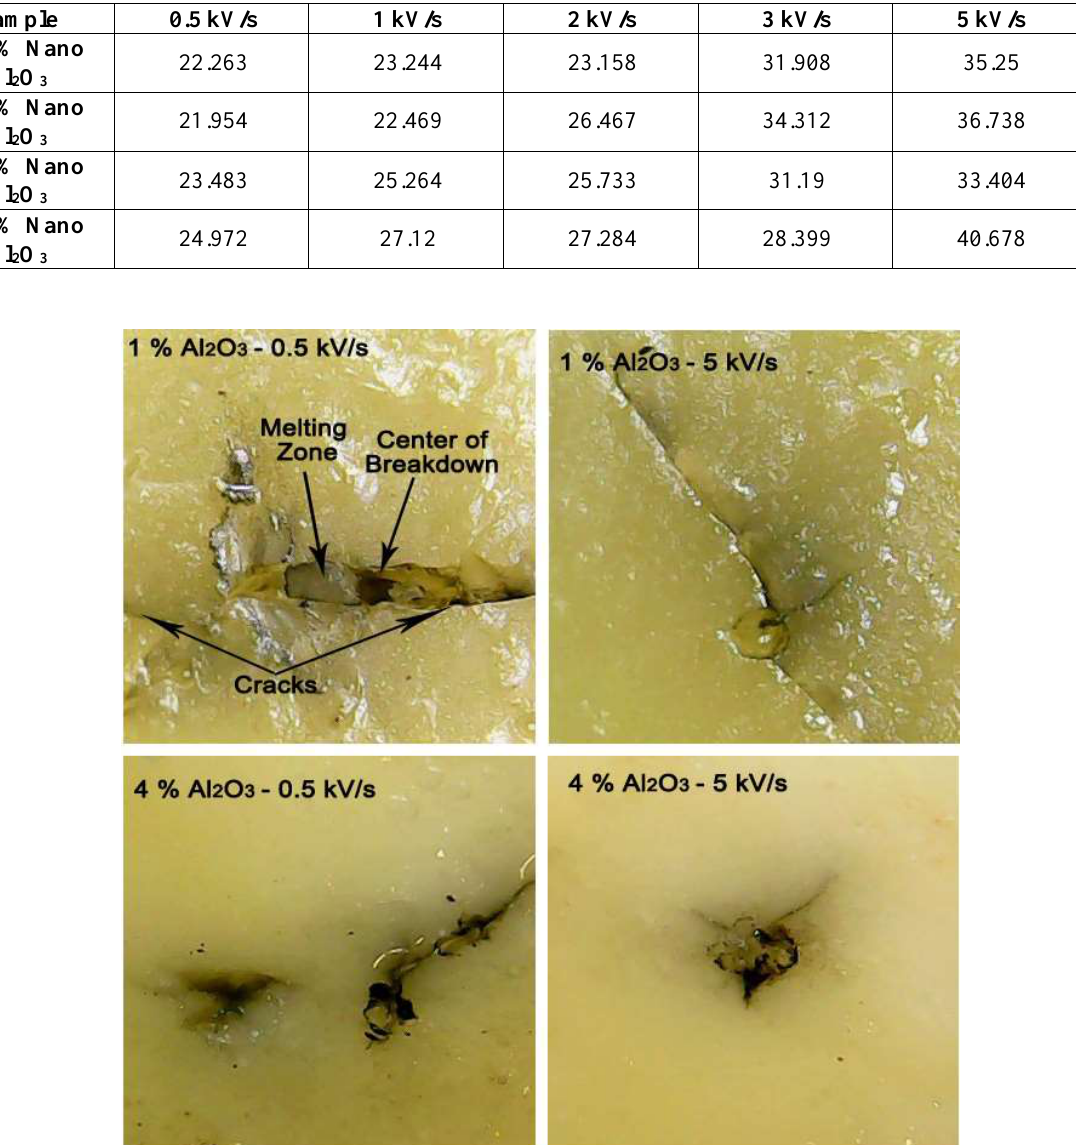
Table 1: Values of Weibull modulus for samples with different RRV.